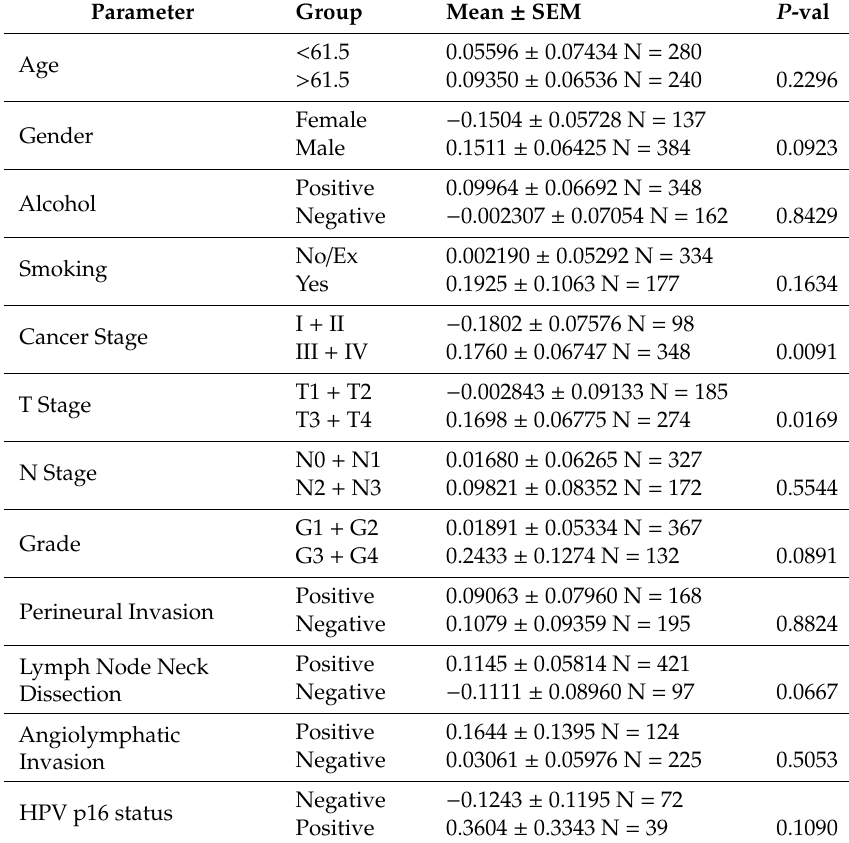
Table 1. The expression levelsof ZFAS1 aredependent onclinicopathological parameters in all localizations of head and neck squamous cell carcinoma (HNSCC). T-test; p < 0.05 considered as significant.